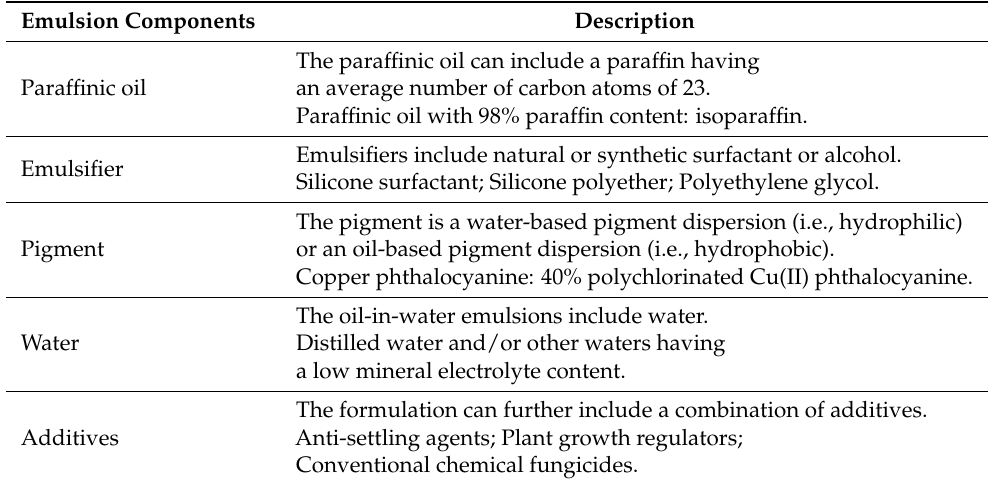
Table 2. Detail of the proposed emulsion-based formulation through the studied patent [9]. Emulsion Components